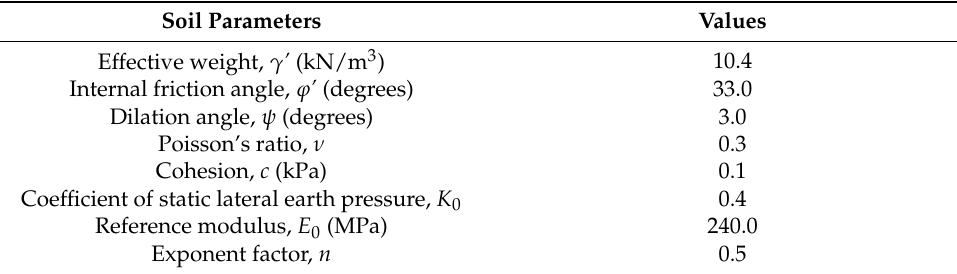
Table 8. Parameters of the soil in Zhugensha sea area.